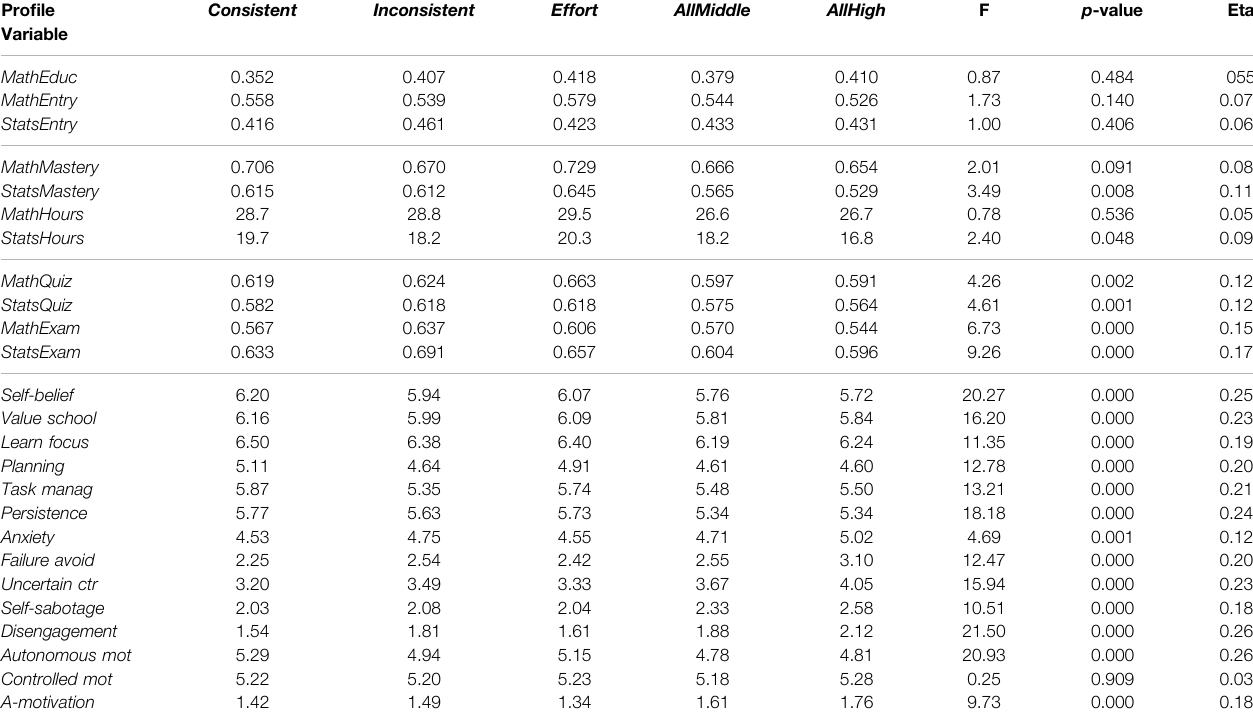
TABLE 2 | Pro fi le means and ANOVA results of mean differences for: students ’ entry characteristics ( fi rst panel), trace data of process type (second panel), course performance data (third panel) and learning dispositions (fourth panel). All ANOVA ’ swere one-way with the clustersas independentvariable and the variable provided in the fi rst column as dependent variable. Degrees of freedom were 4 and 1,142 in all analyses. No post-hoc tests were conducted. Pro fi le